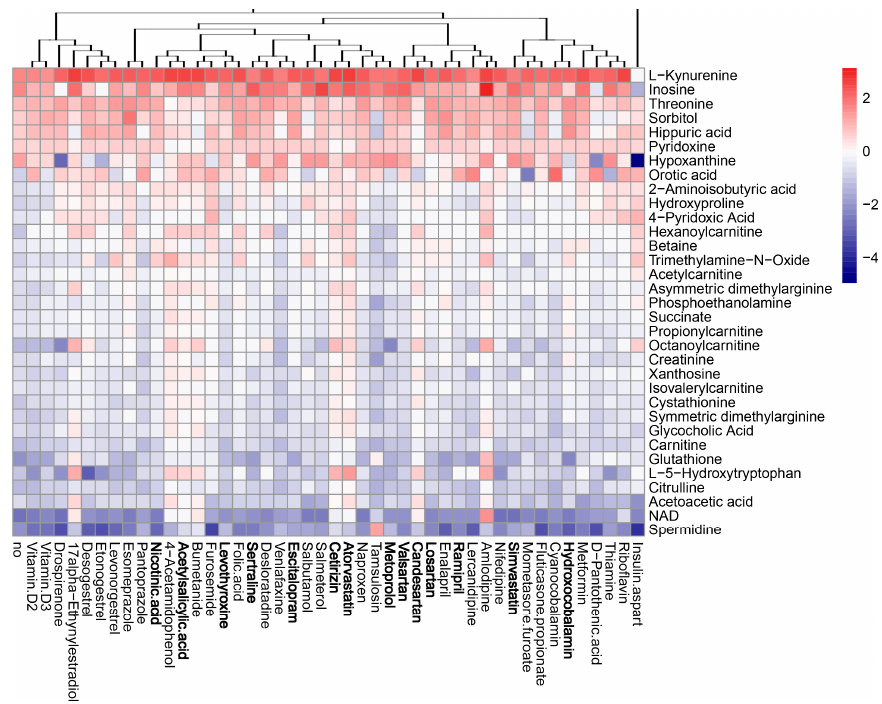
Figure 8. Effect of 45 compounds on metabolism of FLUAV-infected RPE cells. The cells were treated with 10 μ M compounds or remained non-treated. After 24 h, the media were collected, and polar metabolites were analyzed using LC-MS/MS. A heatmap of 33 most variable metabolites affected by treatment is shown. Rows represent metabolites, columns represent treatments with drugs, clustered based on structural similarity. Drugs marked in bold are compounds which were predicted to affect FLUAV–host cell interactions. Each cell is colored according to the log2-trans- formed and quantile-normalized values of the samples, expressed as fold change relative to the non-treated mock-infected control.